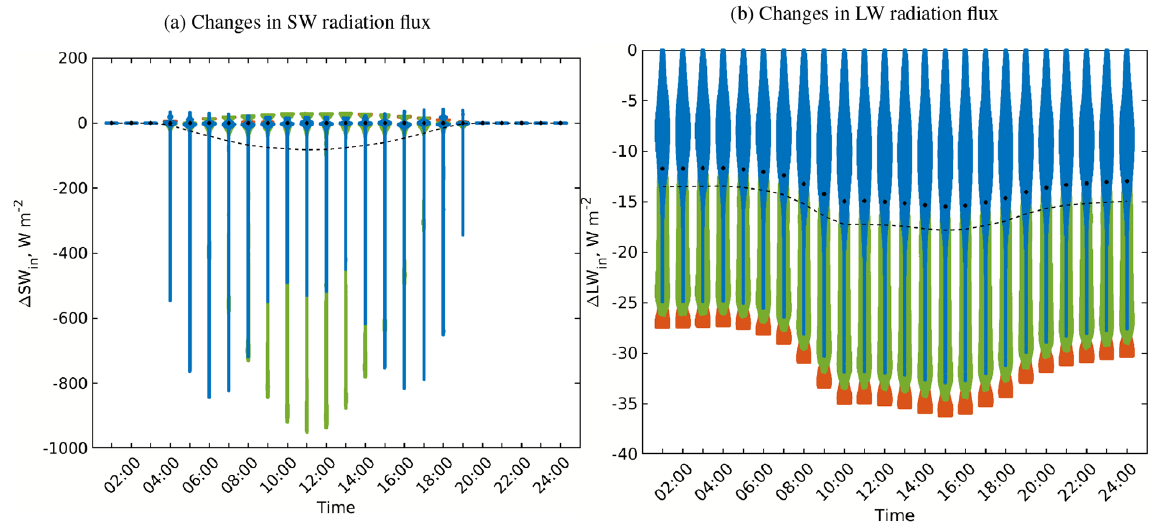
Figure 17. Changes in the received SW and LW irradiance for the surfaces of the realistic urban configuration when considering vegetation interaction with SW solar radiation (RTM_03). Violin, mean, and median colours are used in the same way as those in Fig.